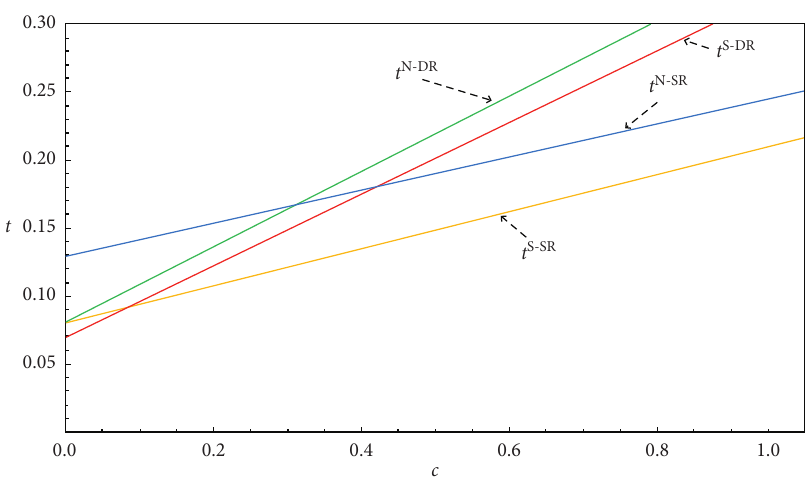
Figure 2: Boundaries of the sharing market.